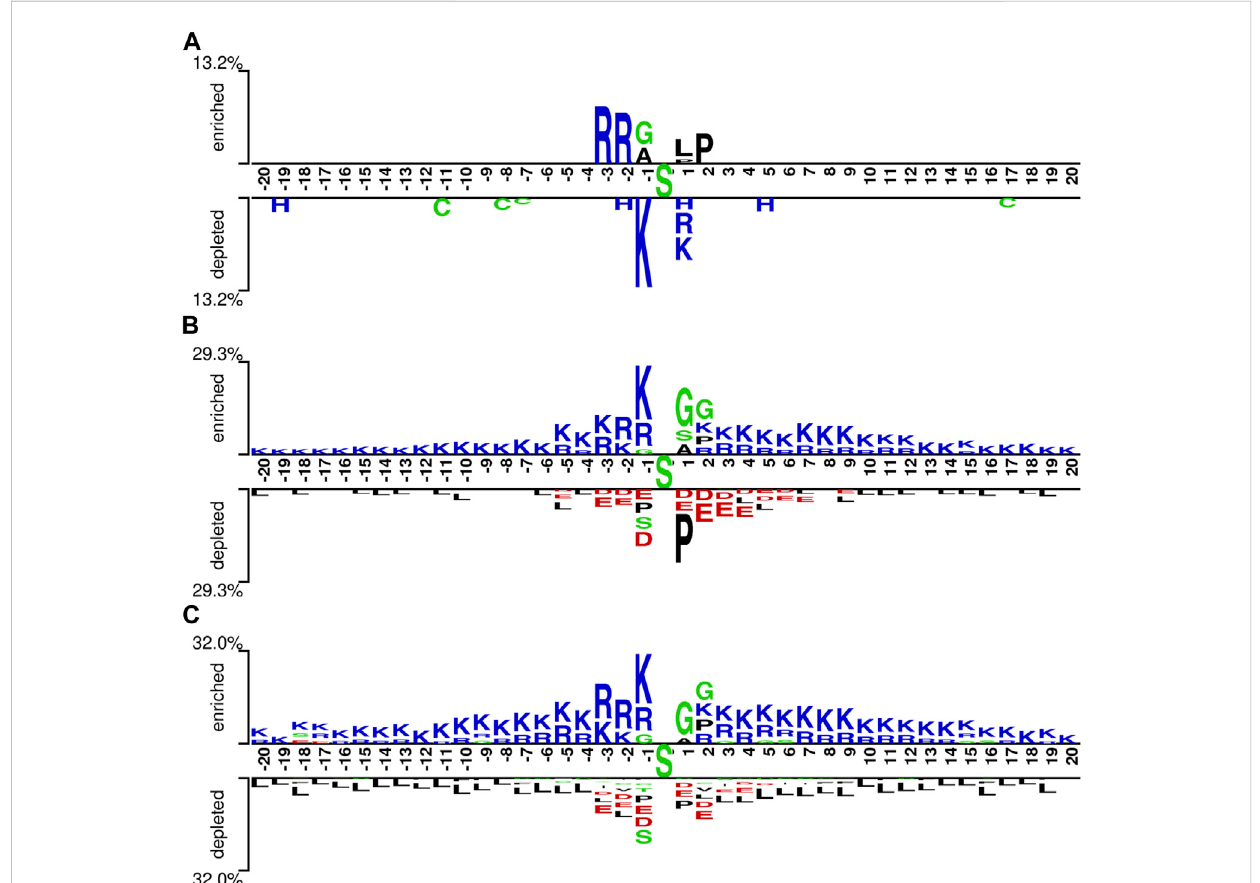
FIGURE 4 Sequence pattern surrounding the pSADPr sites. Enriched and depleted residues fl anking the central pSADPr sites were shown for the pSADPr- SADPr dataset (A) , the pSADPr-pS dataset (B) , and the pSADPr-UM dataset (C) ( p < 0.05, t -test with Bonferroni correction). The patterns were generated using the Two-Sample-Logo program (Vacic et al.,